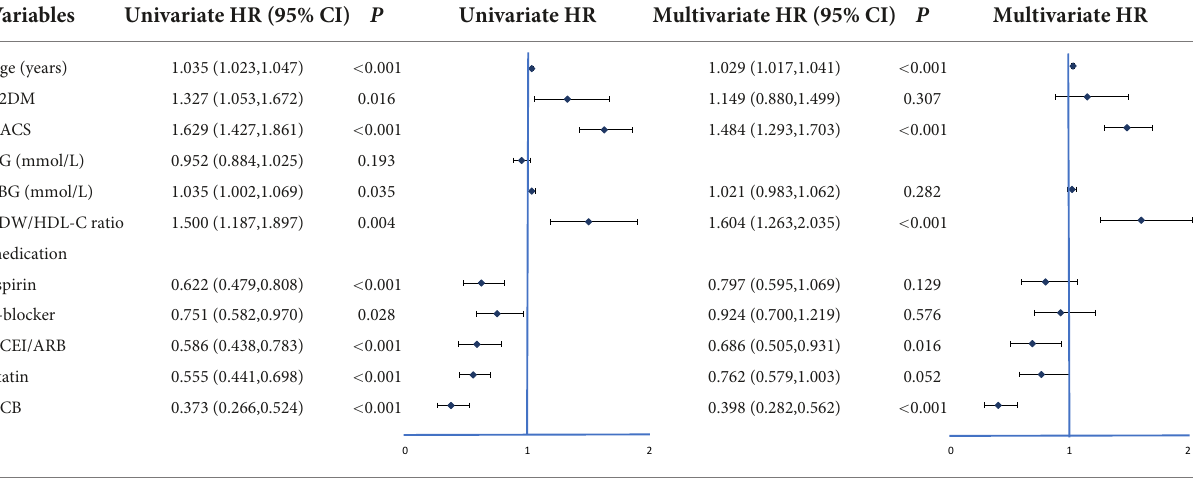
TABLE 3 Univariate and multivariate Cox regression analysis for predicting MACCE.